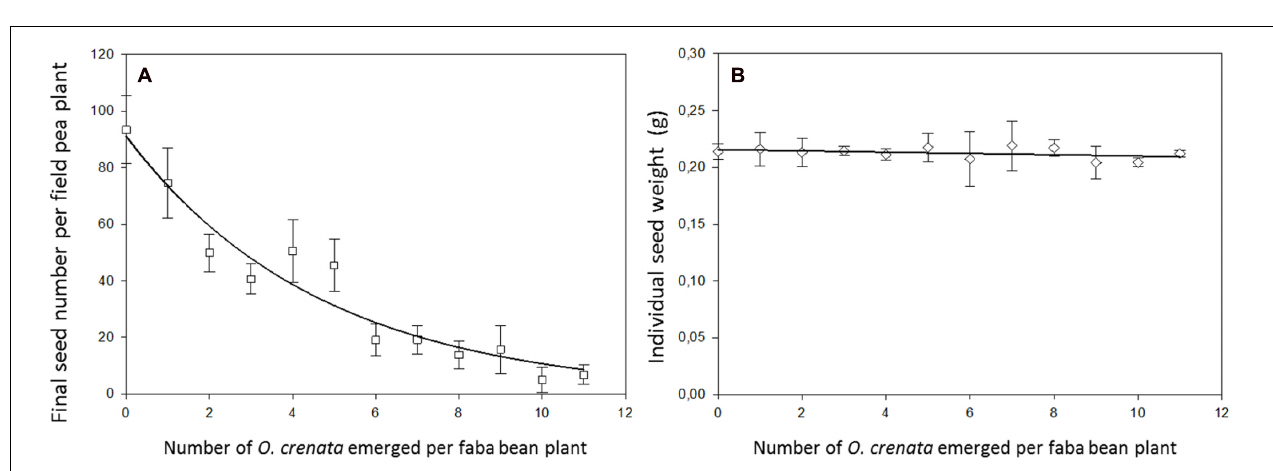
FIGURE 4 | Relationship between seed yield components in faba bean and infection severity. (A) Number of harvested seeds per host plant ( y = 9107 e ( − 0 . 21x ) , r 2 = 0.93, P < 0.0001), (B) Individual seed weight ( y = 0.21 − 0.0006 x ), r 2 = 0.16, P =